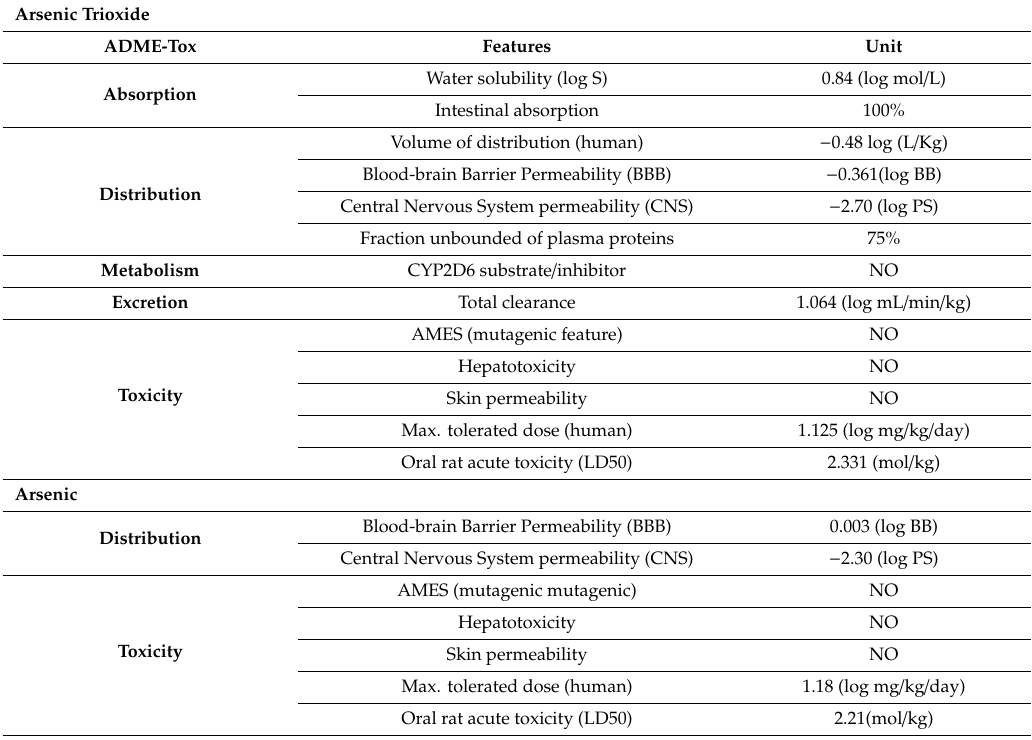
Table 4. Predictive ADME-Tox (absorption, distribution, metabolism, and excretion and toxicity) features of arsenic trioxide and arsenic [27,69].